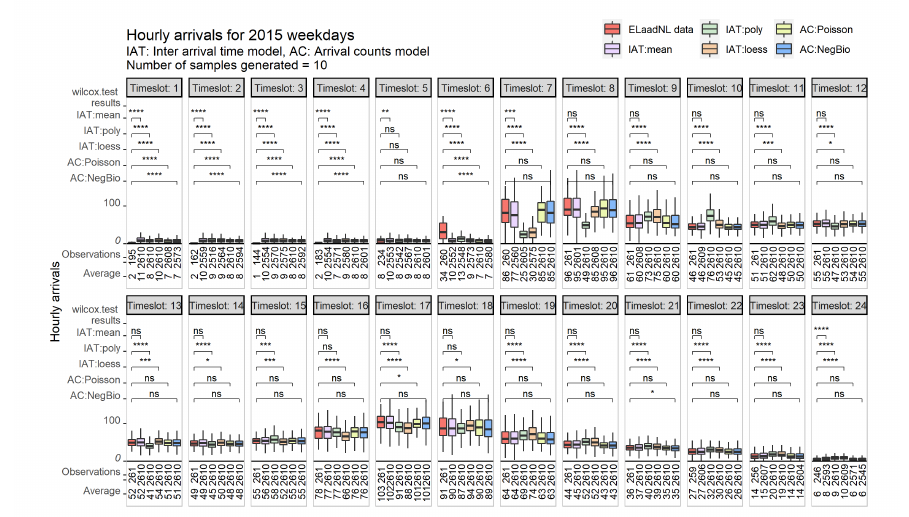
Figure 7. Hourly aggregated EV arrivals (2015, weekdays). Significance was calculated based on Wilcoxon tests ( ns : not significant, p -value > 0.05; * p -value ≤ 0.05; ** p -value ≤ 0.01; *** p -value ≤ 0.001; **** p -value ≤